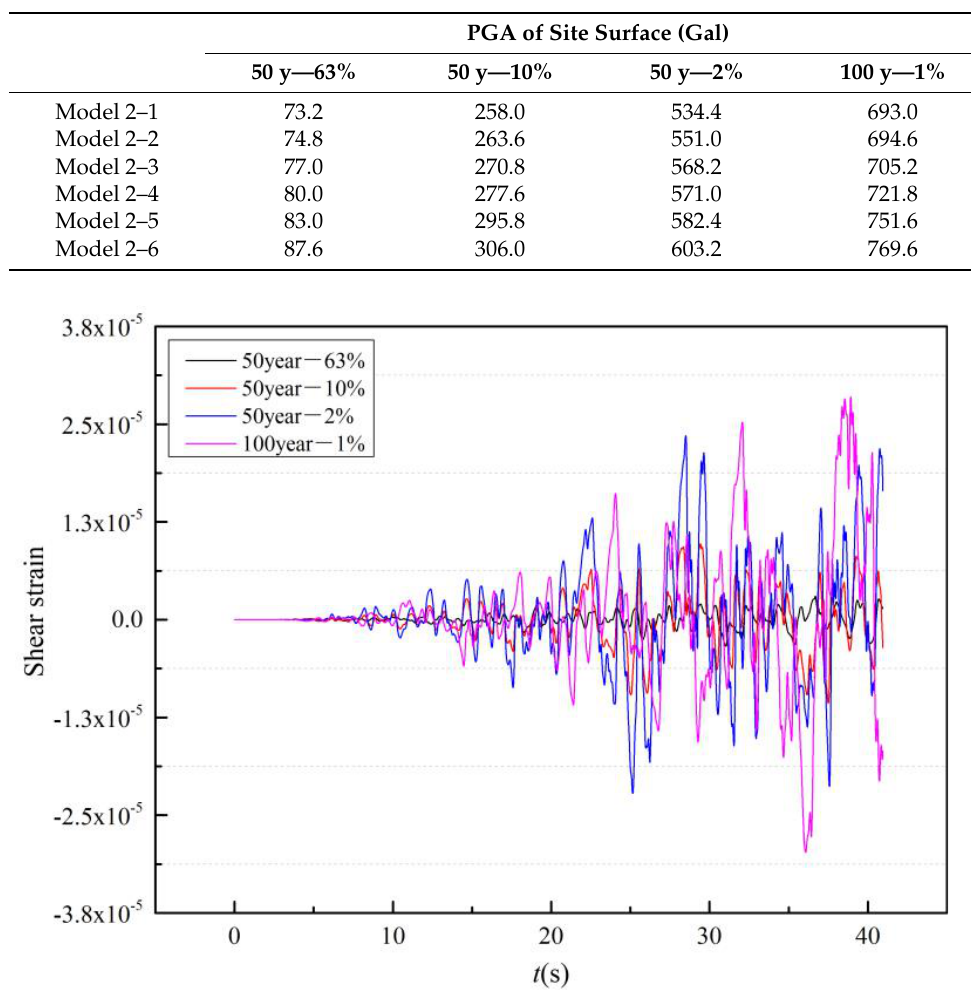
Figure 7. The shear strain under four seismic inputs.